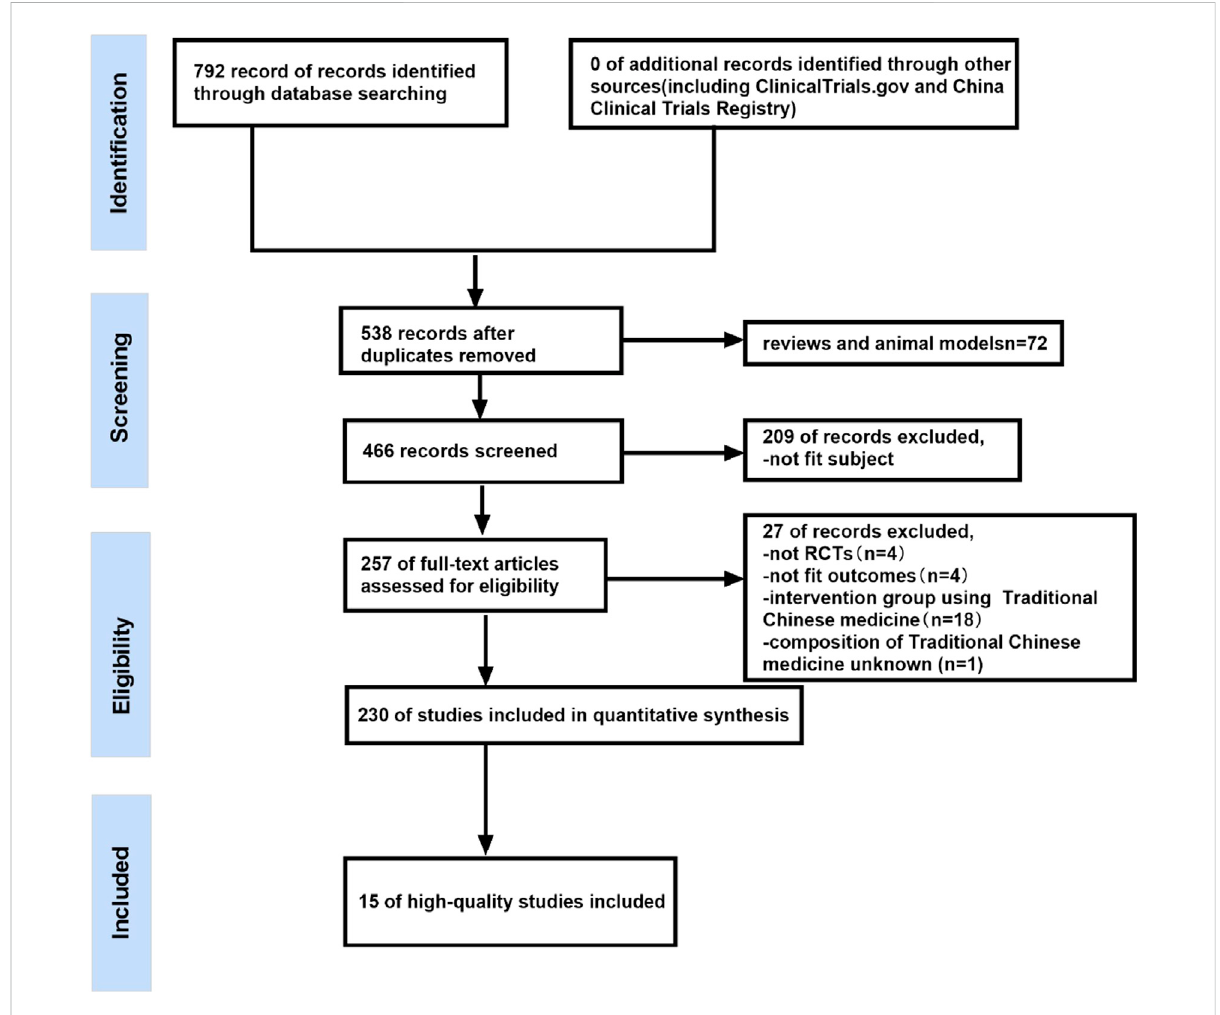
FIGURE 1 Flow chart of the article selection